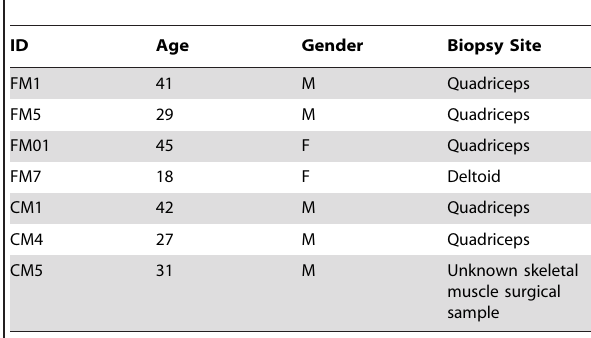
Table 1. Myoblast culture source